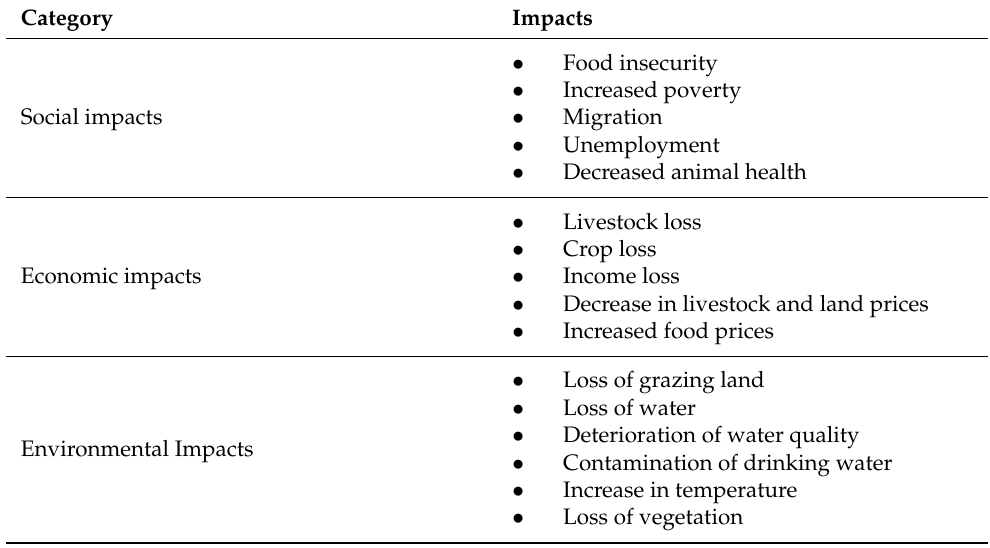
Table 1. Categories of drought impacts identified in South Africa.